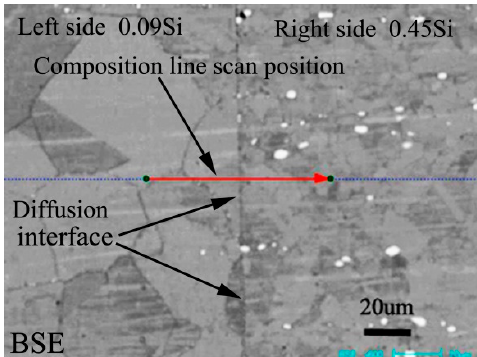
Figure 1. Microstructure of diffusion couple sample after 650 °C/200 h heat treatment: left side is 0.09Si alloy and right side is 0.45Si alloy.